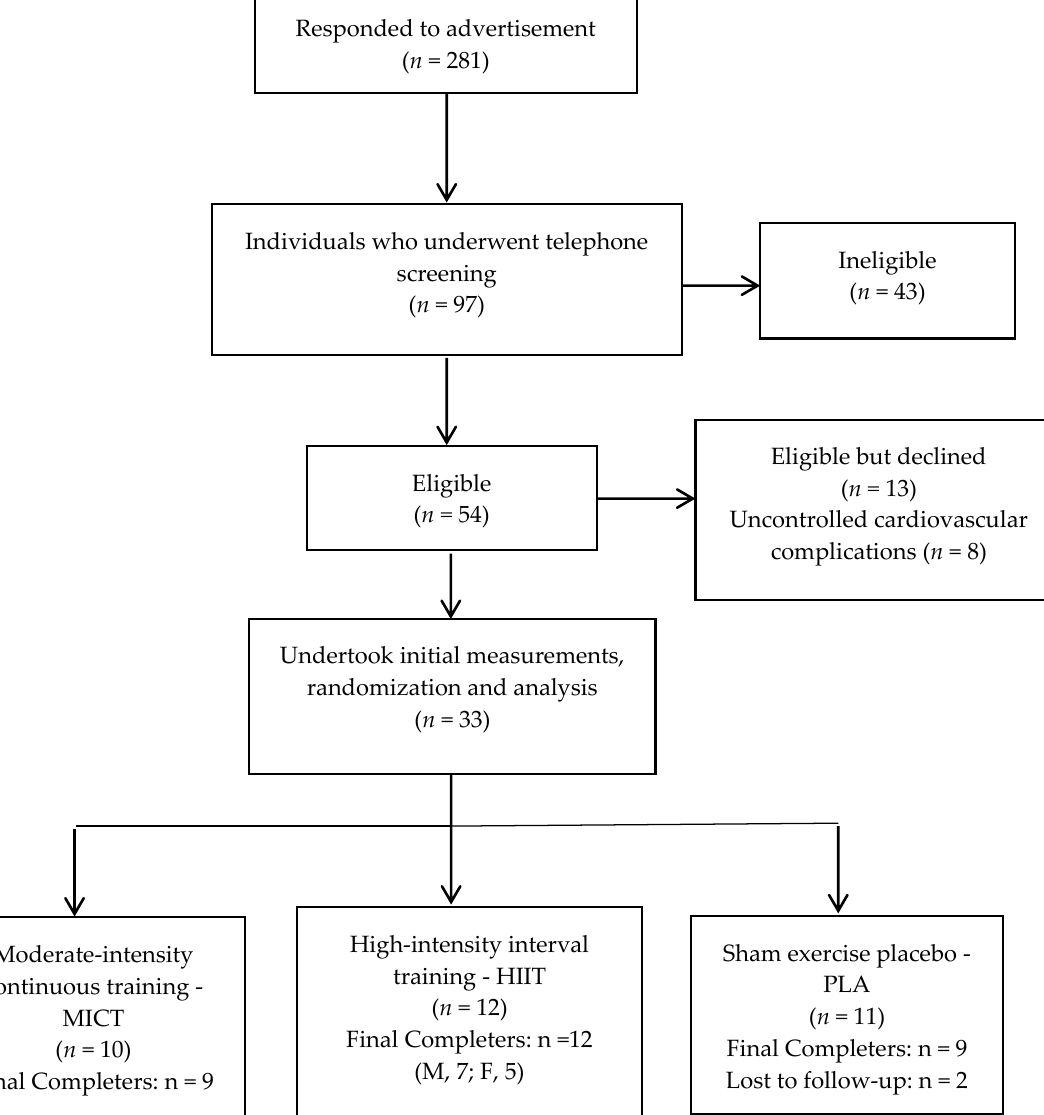
Figure 1. CONSORT flow diagram of participants through the